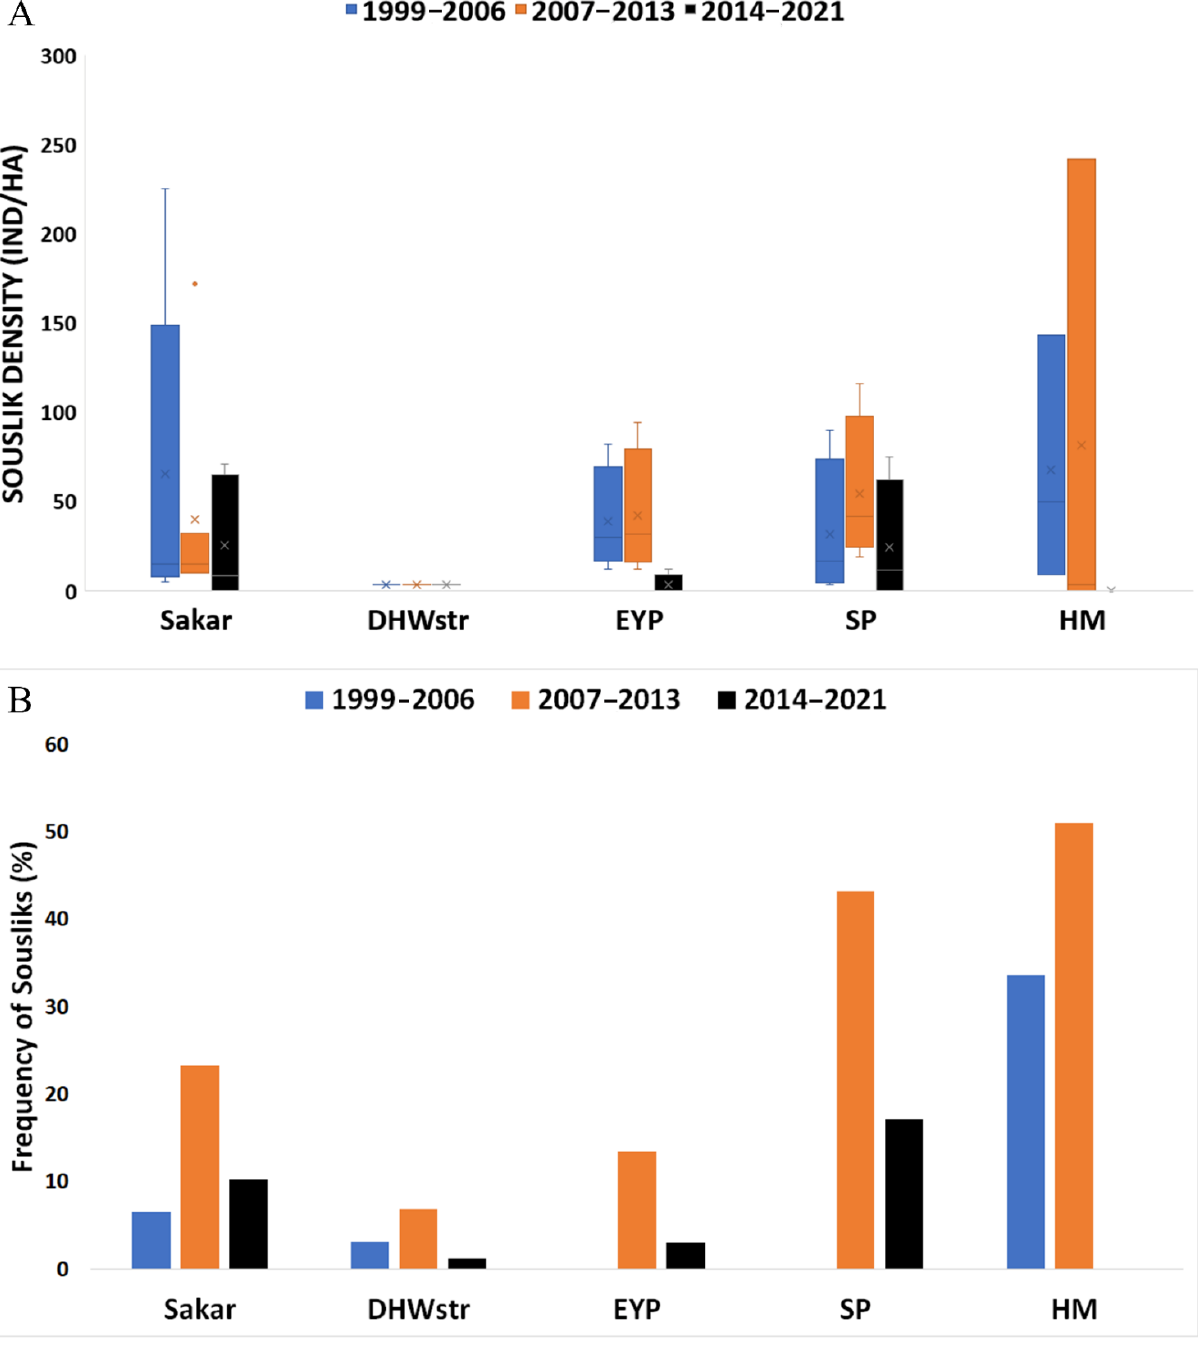
Figure 5. Spatial dynamics of souslik abundance (ind/ha) ( A ) and frequency in the eagle’s diet (%) ( B ) (Eastern Rhodope Mnt. and Sredna Gora Mnt., HM; Sliven plain, SP; Elhovo-Yambol plain, EYP; Dervent Heights-Western foothills of Strandzha Mnt., DHWstr; Sakar Mnt.). The frequency of sousliks in the EIE’s diet followed more or less the same pattern as that of souslik abundance (Figure 5). In the second period, the presence of this profitable prey marginally increased (Tukey’s HSD test = 0.053), followed by a dramatic decline in the last one (Tukey’s HSD test = 0.008). In Sakar Mnt., sousliks reached 23.3% of caught prey between 2007 and 2013 and then dropped to 10.21% ( β 2 = − 0.73, p = 0.004). This prey also shrank significantly its presence in EYP ( β 2 = − 0.80, p = 0.003). With regard to the